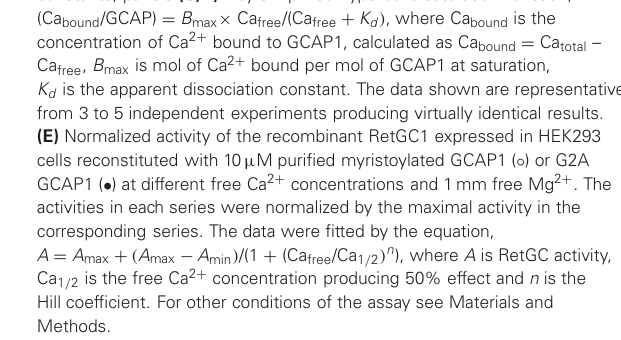
constants; panels (C,D) —by simplified hyperbolic saturation function,